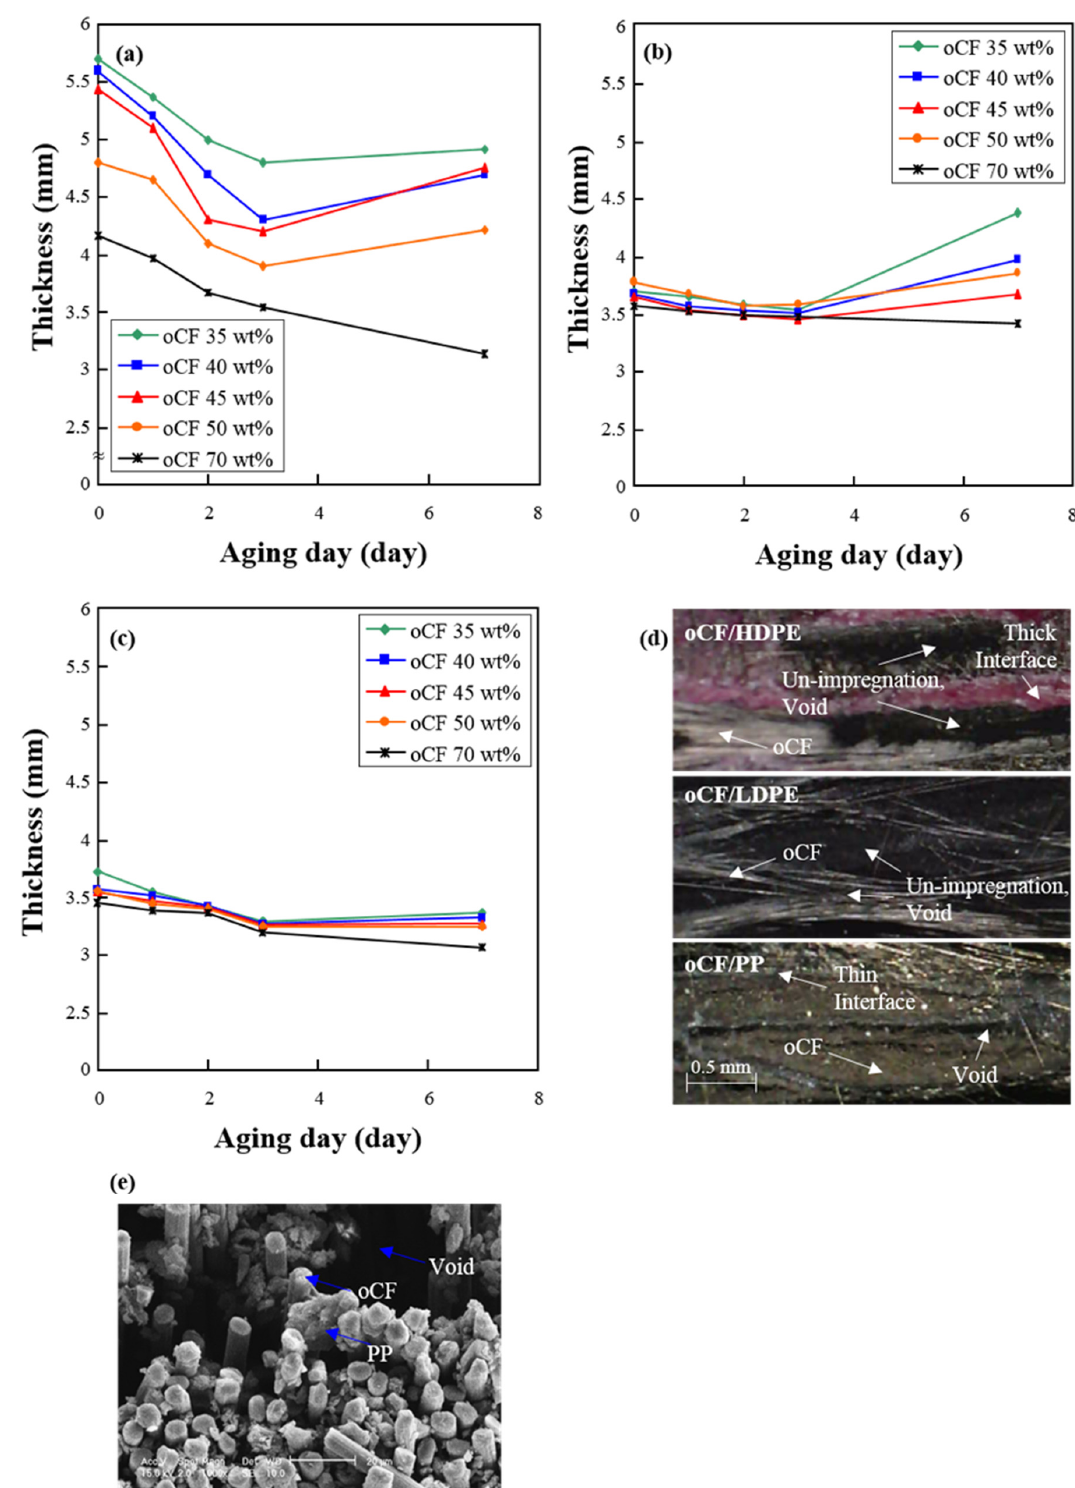
Figure 4. Variation in the thicknesses of oCFOCs by aging days with ( a ) HDPE, ( b ) LDPE, and ( c ) PP, and ( d , e ) cross-sectional images of the 45 wt.% oCFOC with seven aging days.